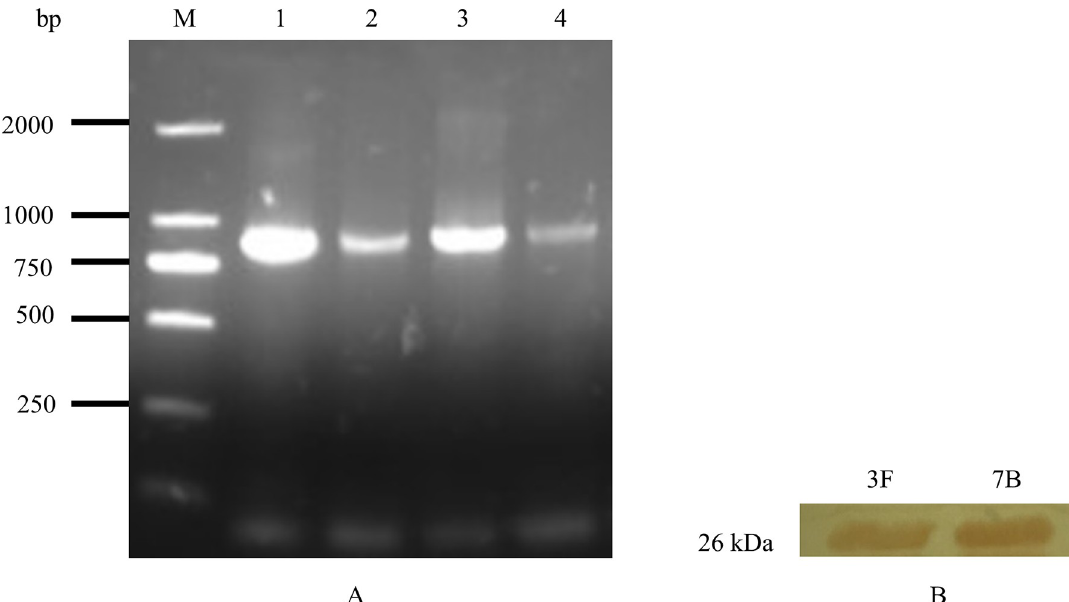
Fig 2. Results of PCR amplification to ELISA positive strains (A) and WB results for 3F, 7B (B). (A) Lane M: DL2000 DNA Maker. Lanes 1 and 4: specific fragments of ELISA-positive strains. (B) Under the same conditions, 3F and 7B exhibited significant advantages over other proteins.